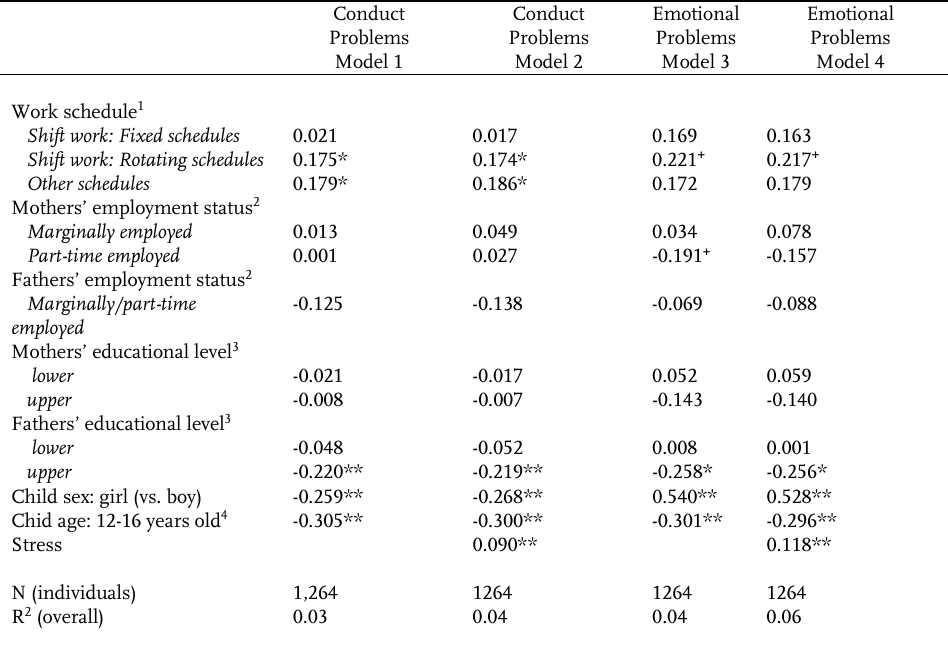
Table 3 : Effects of mothers’ shift-work on children’s conduct and emotional problems (reported by child), random-effects regression Conduct